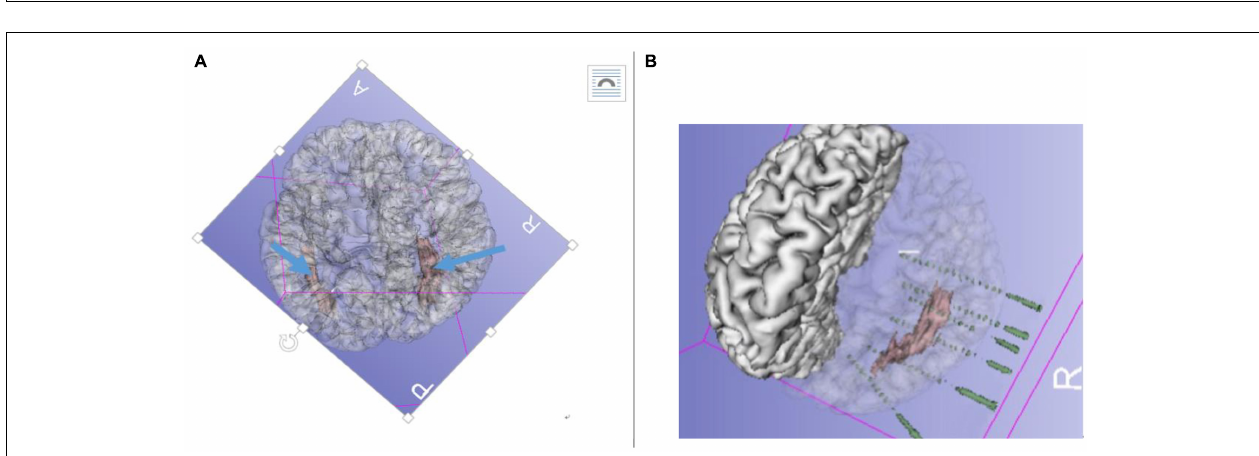
FIGURE 1 | (A) Three-dimensional (3D) MRI showing bilateral periventricular heterotopia and overlying polymicrogyria. (B) T2 Flair of MRI showing asymmetry bilateral periventricular heterotopia and overlying polymicrogyria.